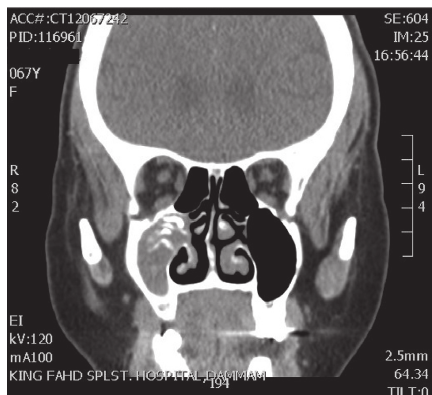
Figure 1: Coronal CTsinuses showing right maxillary sinus fungal ball.